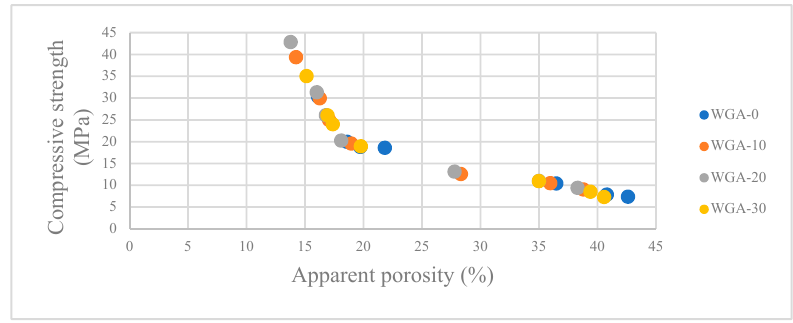
Figure 7. Apparent porosity versus compressive strength.